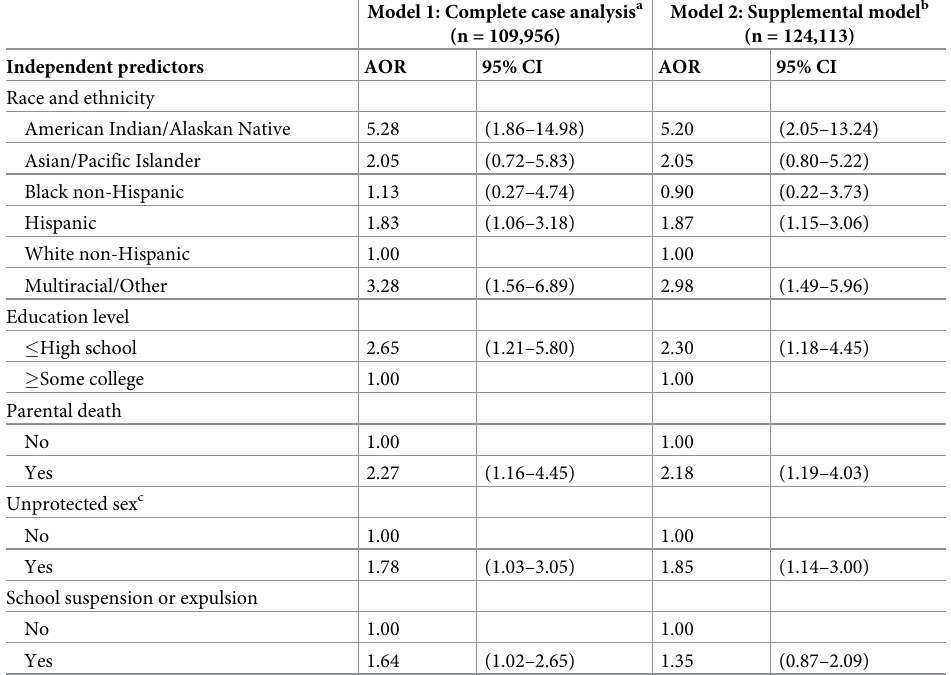
Table 3. Multivariable logistic regression model for sexual offense conviction among U.S. male